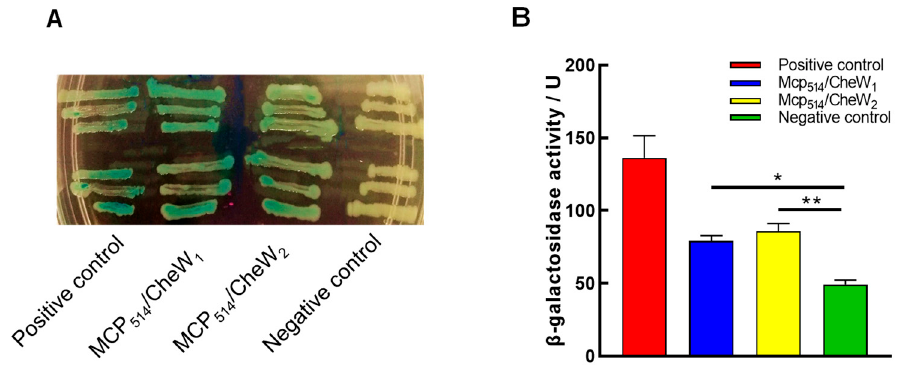
Figure 5. The interactions of MCP 514 with two CheWs of A. fabrum . The interaction between MCP 514 and CheW was tested by using a bacterial two-hybrid assay. All the operations followed the manual. The interaction between two tested proteins will induce the expression of β -galactosidase, and bacterial colonies will show blue color on the X-gal indicator plate. ( A ) Colony color on the X-gal indicator plate. ( B ) The activity of β -galactosidase reporter induced by the interacting proteins. Data are the means ± SDs from three independent experiments with triplicate. The bars paired with “*” and “**” marks represent that they are different in a statistical manner at p < 0.05 and 0.01, respectively via the one-way ANOVA, followed by Tukey test. Positive control, interaction between two known proteins (LGF2 and Gal11 p ) provided by the manufacturer; MCP 514 /CheW 1 , interaction between MCP 514 and CheW 1 ; MCP 514 /CheW 2 , interaction between MCP 514 and CheW 2 ; negative control, without any interacting proteins.